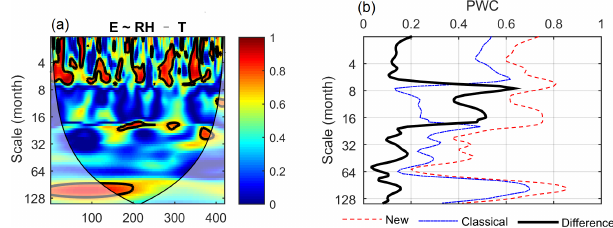
Figure 5. PWC between evaporation ( E ) and relative humidity (RH) after excluding the effect of mean temperature ( T ) using the classical implementation (Eq. 15) (a) and differences in PWC be- tween the new (Eq. 14) and classical implementations as a function of scale (b)